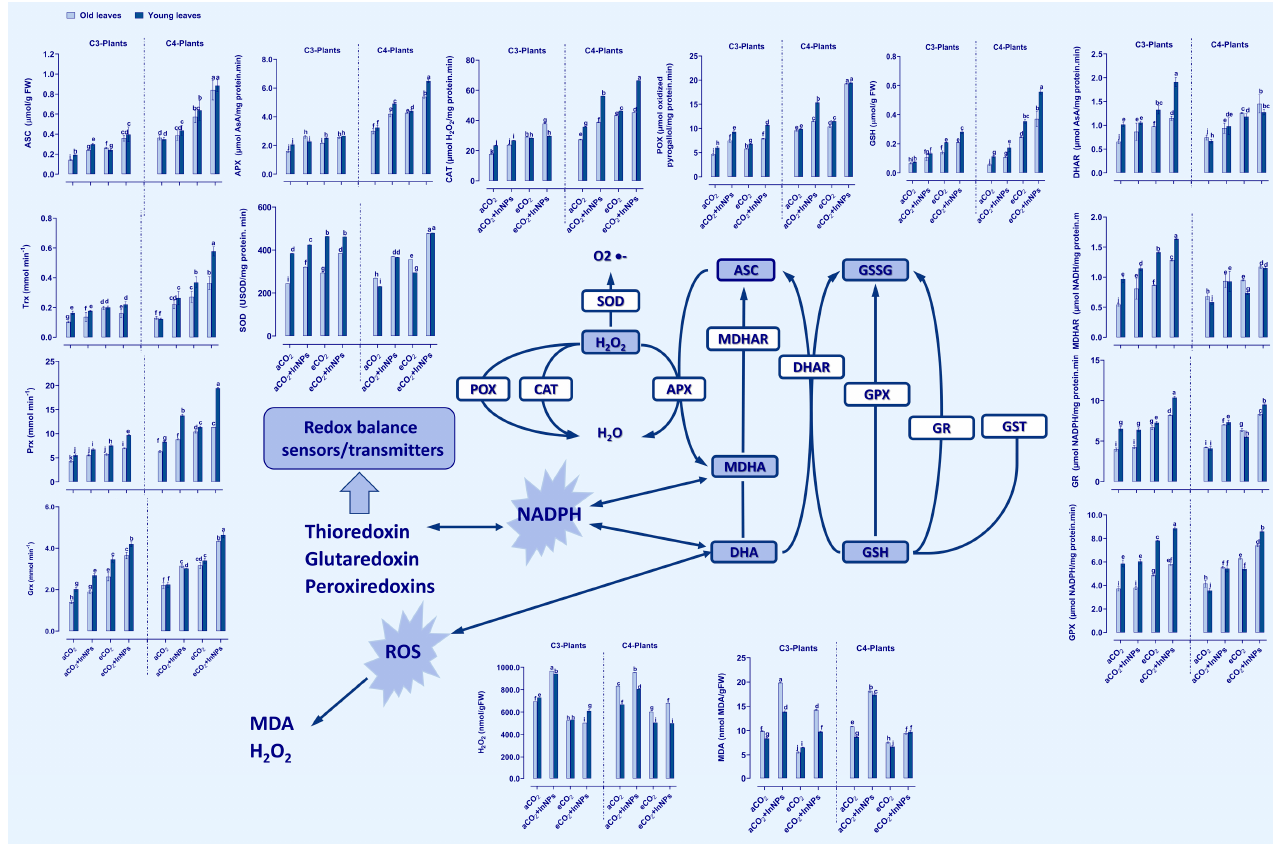
Figure 3. Effect of In2O3-NPs either alone or in combination with eCO2 upon the activities of antioxidant scavenging enzymes as well as the oxidative damage in both old and young leaves of C3 and C4 plants. Four biological replicates are used to demonstrate each value. The vertical error bar represents the standard error (SE). Fisher’s LSD test (p < 0.05; n = 4) was used to compare the data for each response separately. Different letters indicate significant differences between means in young and old leaves of C3 or C4 plants.